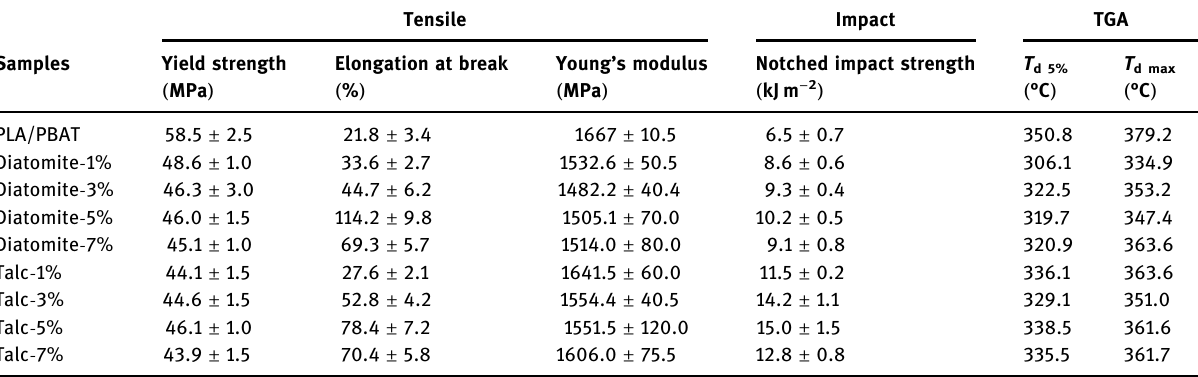
Table 2: The mechanical properties and thermal stabilities of the blends Tensile Impact TGA Samples